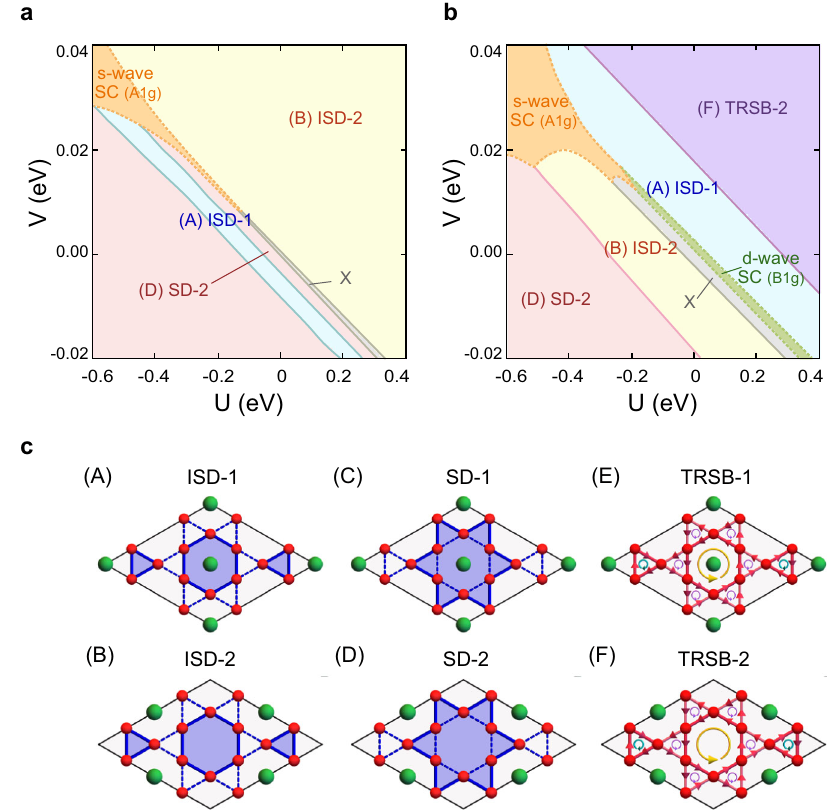
Fig. 4 | Phase diagrams at T → 0 + and corresponding electronic orders in the A V 3 Sb 5 monolayer. a , b Phase diagrams at the chemical potentials a and b μ 2 =35meV in U - V space, where U and V are the onsite and the nearest neighbor density-density type interactions. Different CDW and SC orders are indicated by different colors. The gap functions of s-wave and d-wave super- conducting states correspond to A ð 1 Þ g and B ð 1 Þ 1 g provided in Table 2. The super- conductingphasesonlyexistatzerotemperatures,and theirphaseboundariesare denoted by dashed lines to contrast the boundaries of commensurate CDWs denoted by the solid lines. X denotes a phase unidenti fi ed within our mean- fi eld